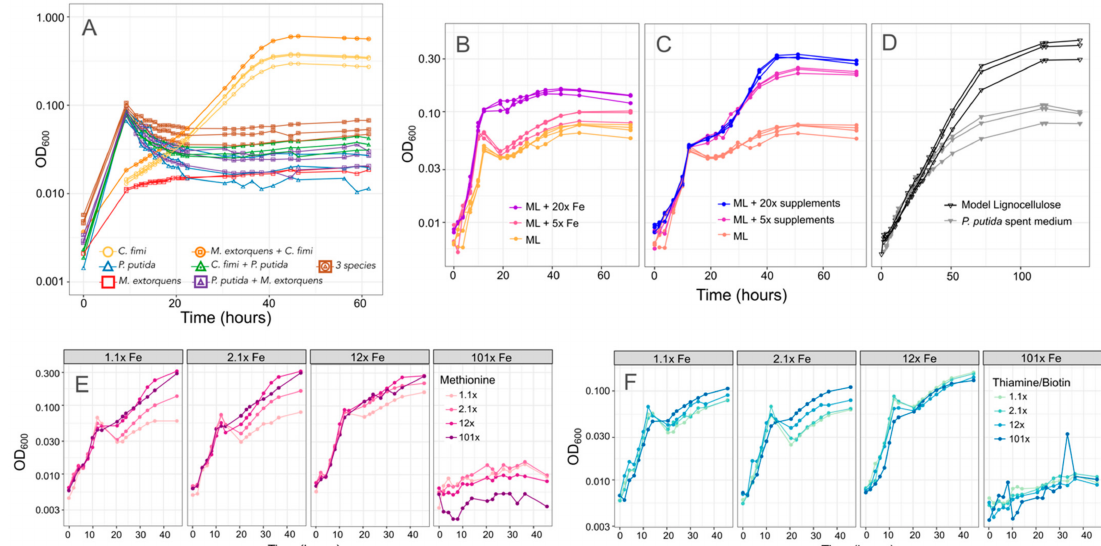
Figure 8. There are multiple potential explanations for the inhibitory effect of P. putida on C. fimi growth. ( A ) Growth of individual species and combinations (denoted by color and shape of plot symbol) on Model Lignocellulose medium in which vanillic acid is replaced by protocatechuic acid, which does not result in formaldehyde production. Cultures with P. putida still show slower growth than those without. ( B , C ) Effect of increasing the iron or supplements (methionine, thiamine, and biotin) in the medium. In both cases, higher concentrations support more growth. ( D ) Growth of C. fimi alone on either Model Lignocellulose or P. putida spent medium: a lower final yield is reached on spent medium. ( E , F ) Growth of the model community ( P. putida, C. fimi, M. extorquens ) on combinations of different iron (panels), methionine (color scale), and thiamine + biotin (color scale)